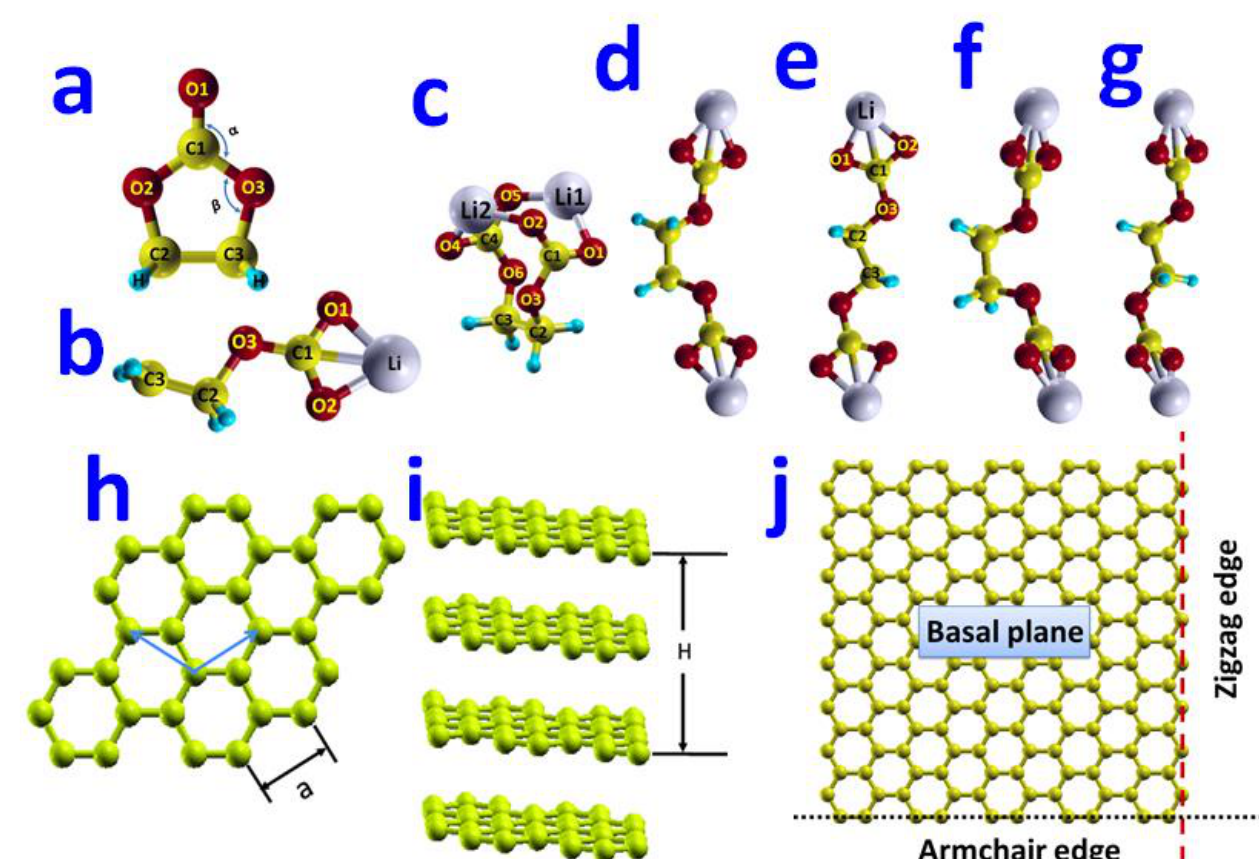
Figure 1. ( a ) Atomic structure of EC molecule determined by the DFT method. In the figure, red, yellow, blue balls represent oxygen, carbon, hydrogen atoms, respectively. ( b ) The most energetically favorable atomic structure of CH 2 CH 2 OCO 2 Li. In the figure, red, yellow, blue, and white balls represent oxygen, carbon, hydrogen, and lithium atoms, respectively. ( c ) gauche , ( d ) cis , ( e ) trans , ( f ) twisted cis , ( g ) twisted trans configuration of (CH 2 OCO 2 Li) 2 . ( h ) The two arrows form the lattice vectors for the primitive unit cell on the basal plane of graphite. ( i ) The side-view of atomic structure of the bulk graphite. ( j ) The schematic plot of basal surface, armchair edge (dotted line), and zigzag edge (dashed line).